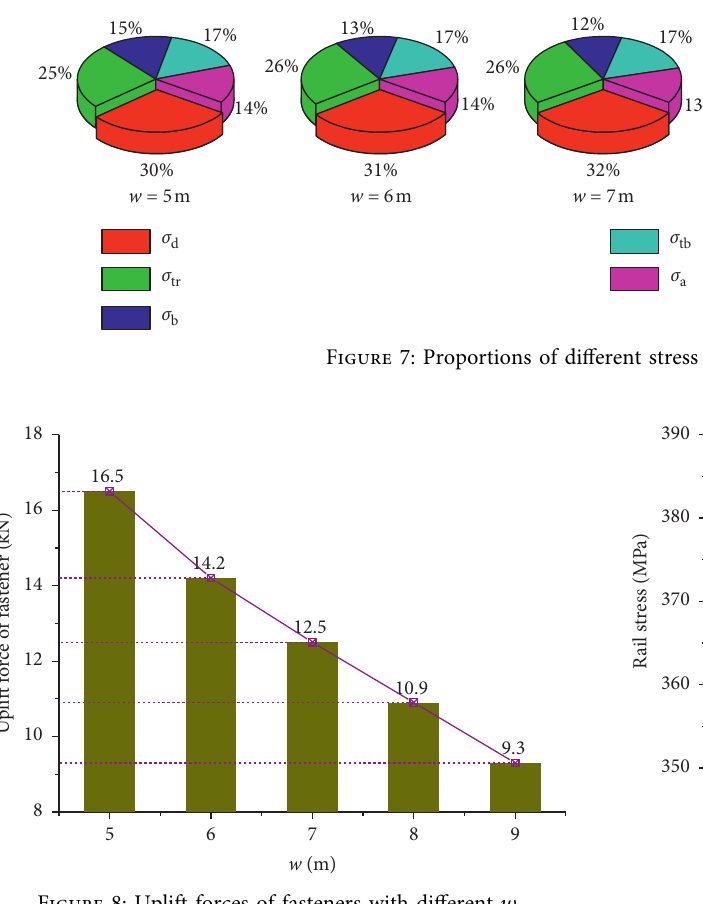
Figure 8: Uplift forces of fasteners with different w .